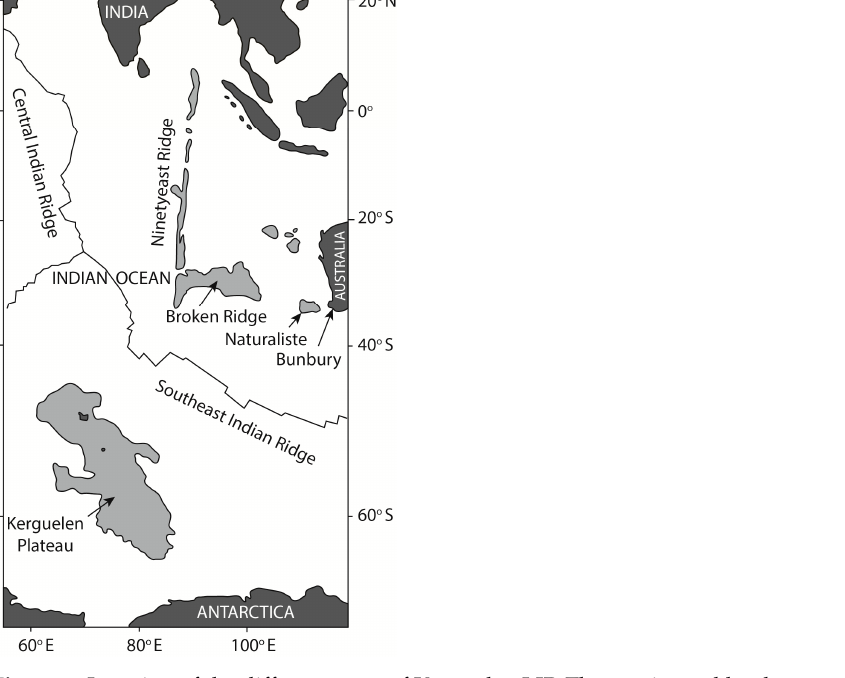
Figure 1. Location of the different parts of Kerguelen LIP. The continental landmasses are shown in black and the submarine plateaus and ridges are shown in grey.